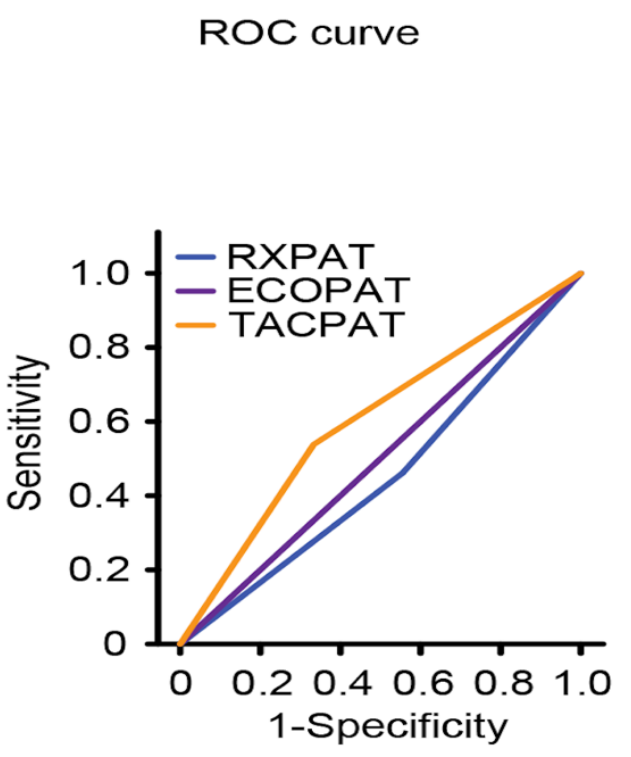
Figure 2. Comparison of the areas under the curve for pathological lung ultrasound, pathological chest CT and pathological chest